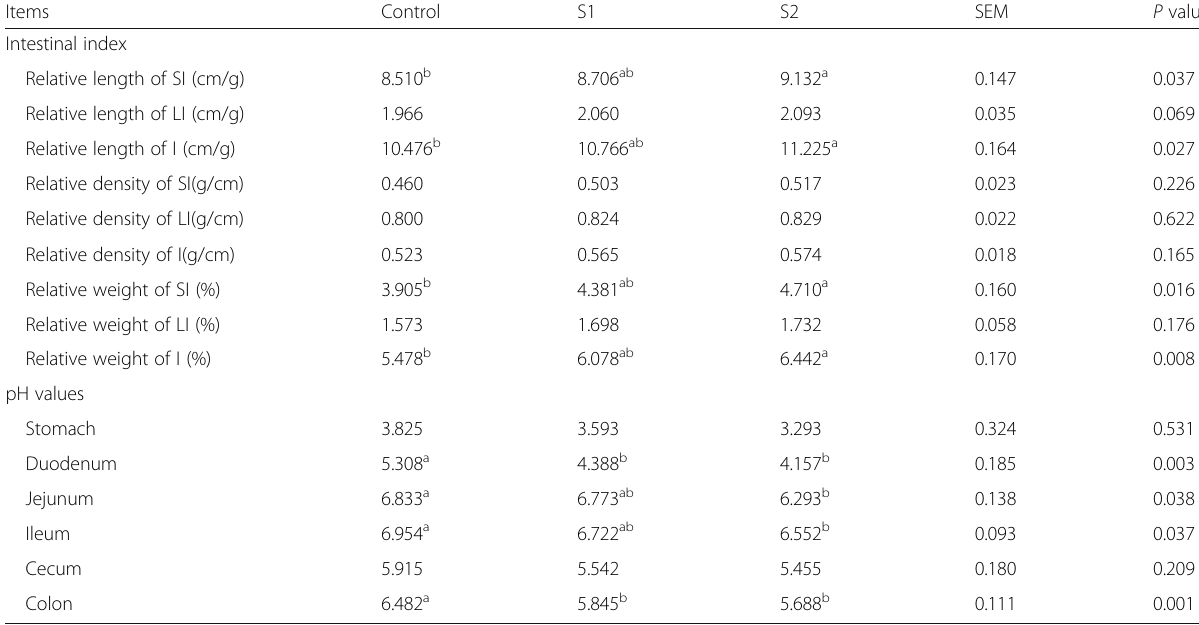
with the control group ( P < 0.05). Meanwhile, the GPR43 protein level of jejunum and colon in the S1 and S2 groups were higher than that in the control group, and pigs of S2 group had higher GPR43 protein level in the jejunum than pigs of S1 group (Figs. 7 and 8, P < 0.05). Table 2 Effect of gastric infusion of SCFA on intestinal index and pH value of digesta in weaned